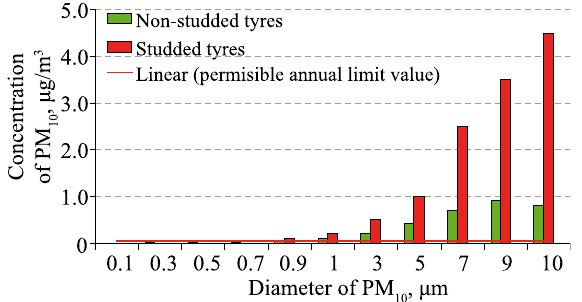
Fig. 5. Dependency of PM 10 emission concentration on particle diameter, when a passenger car travels at a speed of 30 km/h by Ketzel et al.